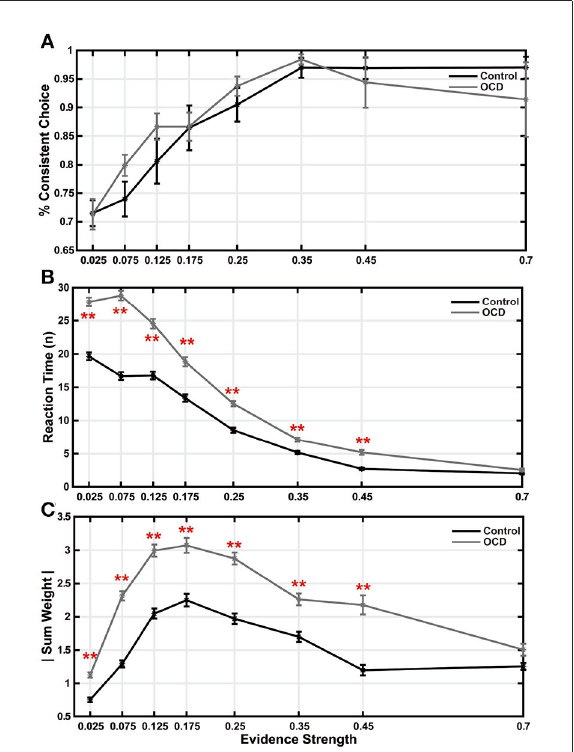
FIGURE3 Trial difficulty affected decision making. (A) Accuracy is plotted as a function of evidence strength. There were no significant differences between the two groups. (B) Reaction time. (C) Sum weight. All the data points and the error bars indicate the mean and the S.E.M. across subjects (** p < 0.01, two-sample t -test, after multiple comparison